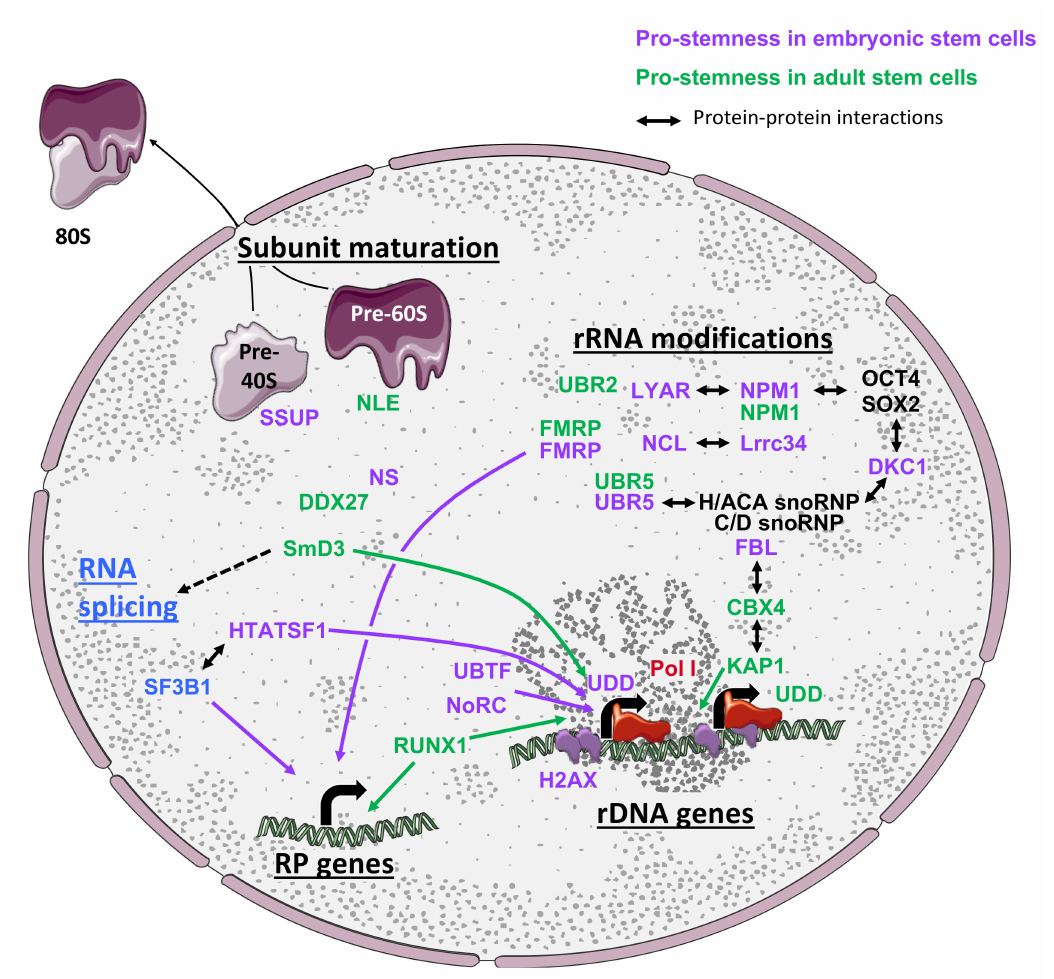
Figure 2. Ribosome biogenesis is highly regulated in embryonic and adult stem cells. Key RBFs described in this review and their implication in ribosome biogenesis in stem cells are presented. Factors stimulating ESC and ASC maintenance are depicted in purple and green, respectively. Direct protein / protein interactions are indicated by double-headed black arrows. Images of nucleic acids, the nucleus, and proteins were kindly provided by the SMART Servier medical art database